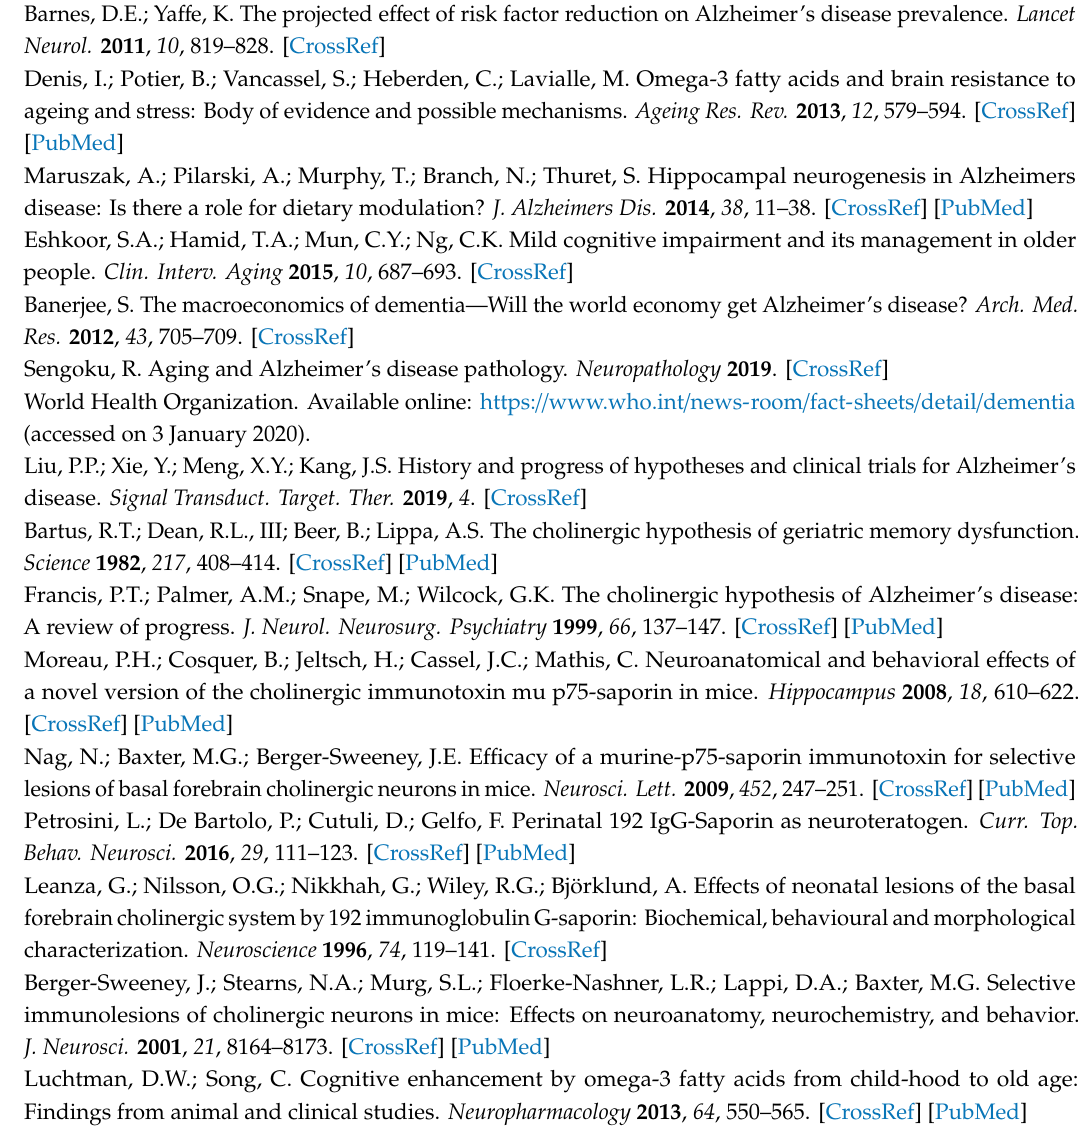
Scale bar: 100 µ m. Table S1. Duration (s) and frequency of single social and non-social behaviors observed in the four experimental groups during SI. Table S2. Duration (s) and frequency of single strategies displayed by the four experimental groups during